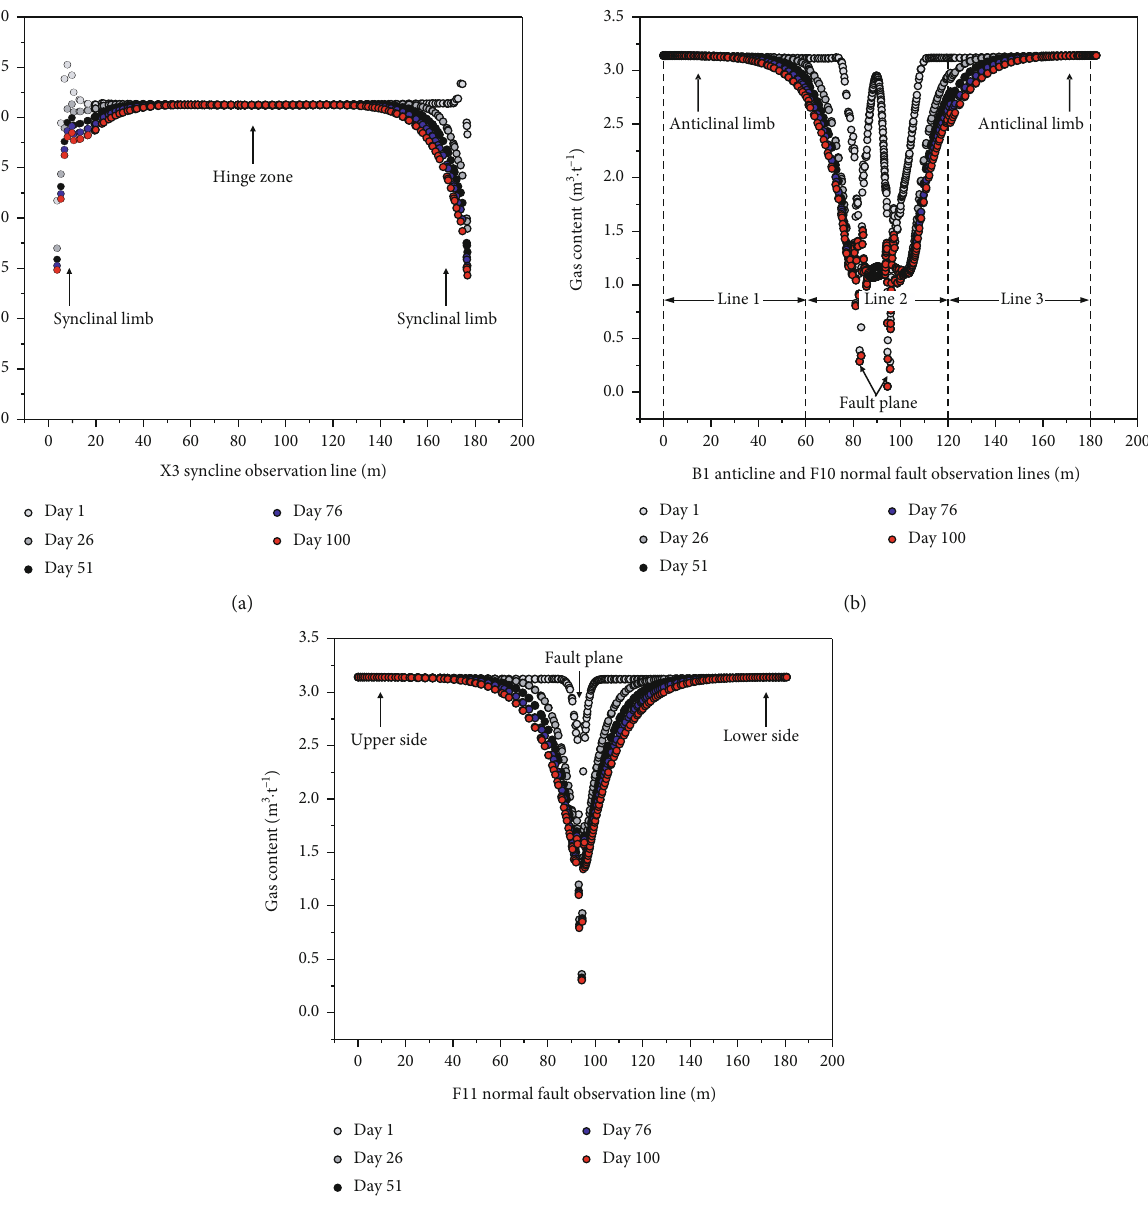
Figure 10: Variation of CBM content near di ff erent tectonic types: (a) variation of CBM content near the X3 syncline structure; (b) variation of CBM content near the B1 anticline and F10 normal fault structure; (c) variation of methane content near the F11 normal fault